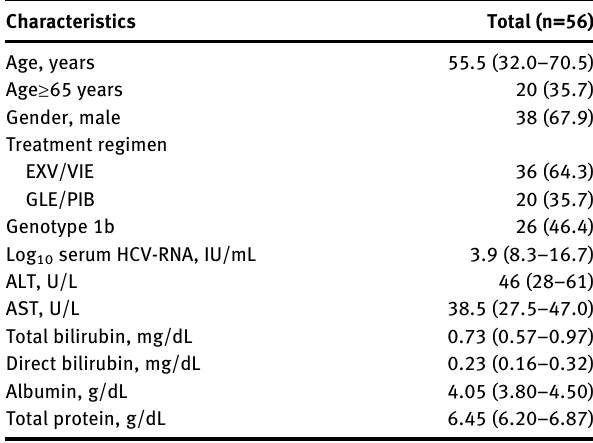
Table  : Baseline characteristics of the patients with CHC.